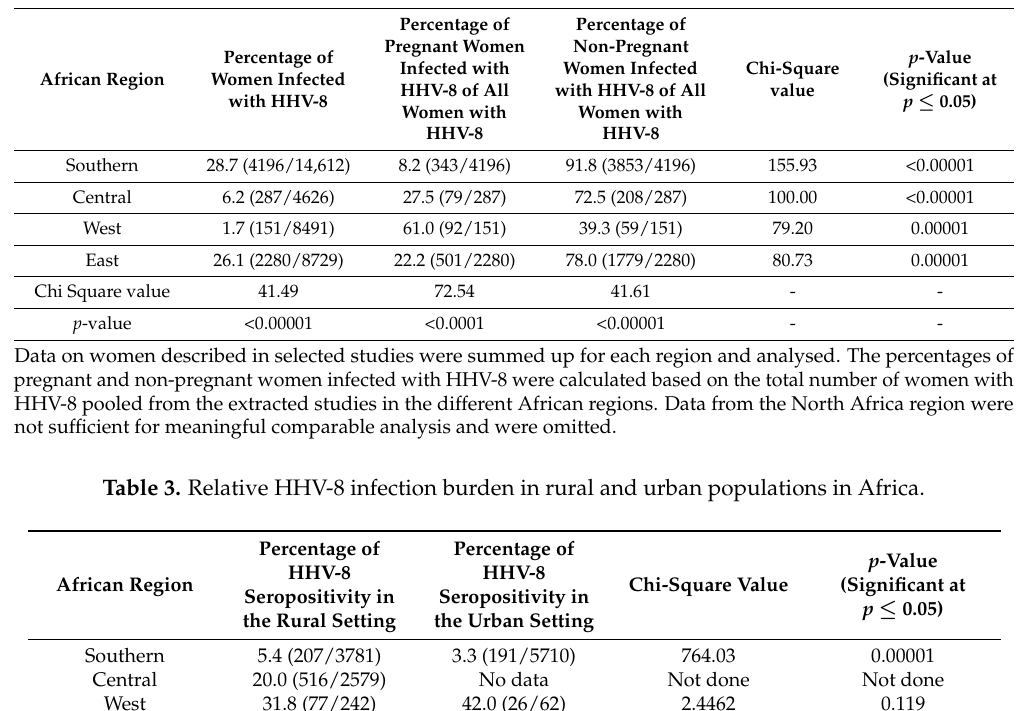
Table 2. Relative HHV-8 infection burden in women of comparable age (25–45 years) in Africa.